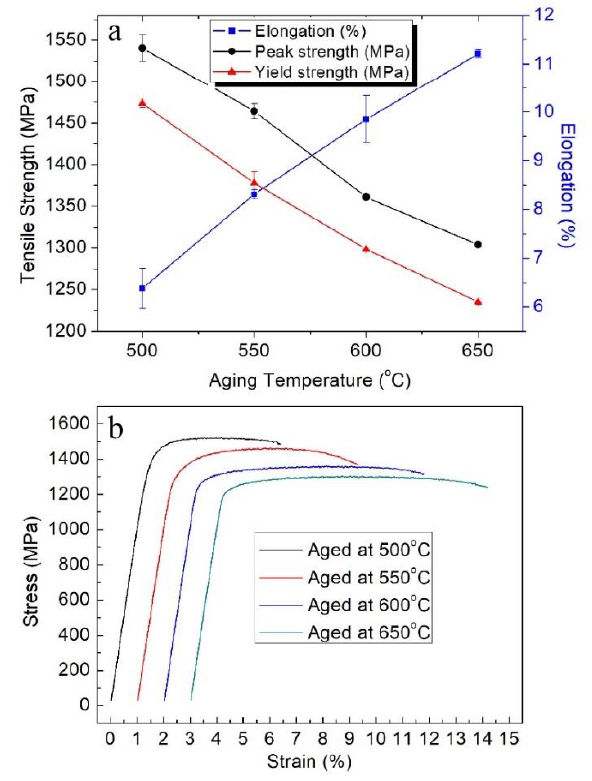
Figure 15. Tensile test results of the alloy solution treated at 820 °C and aged for 6 h: ( a ) tensile properties vary with aging temperature; ( b ) stress-strain curves.